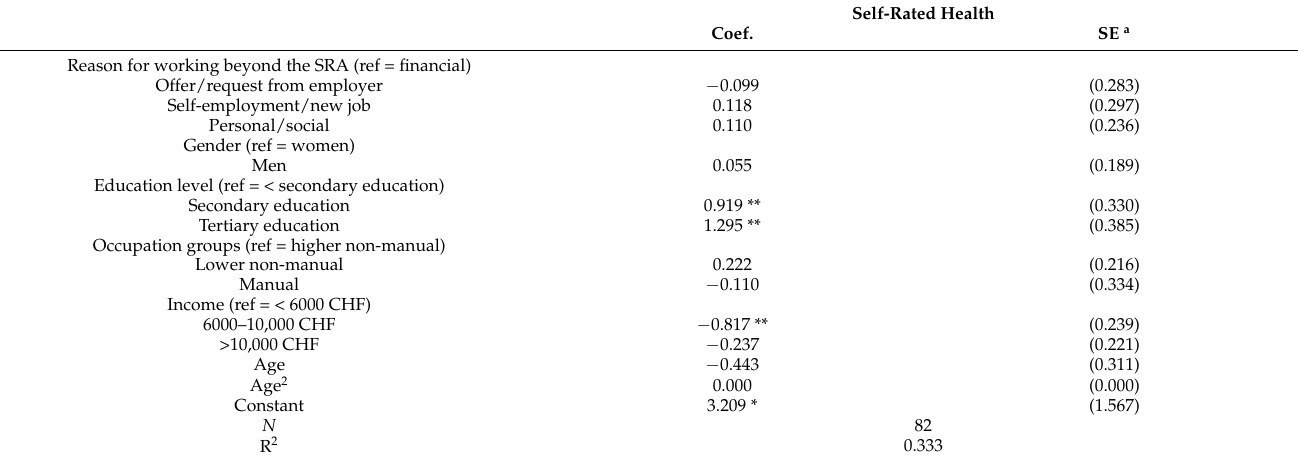
Table 4. OLS regression for self-rated health.